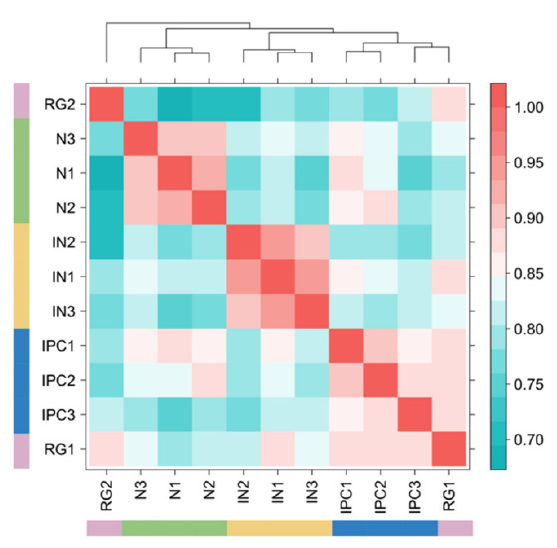
Figure 6. HiCRep excluding NOT pairs in human neural PLAC-Seq datasets. HiChIP dataset consisted of three neurons, three interneurons, two radial glial, and three intermediate progenitor cell samples excluding interactions where neither bin overlapped with an anchor. Red color signifies results indicating stronger correlation.